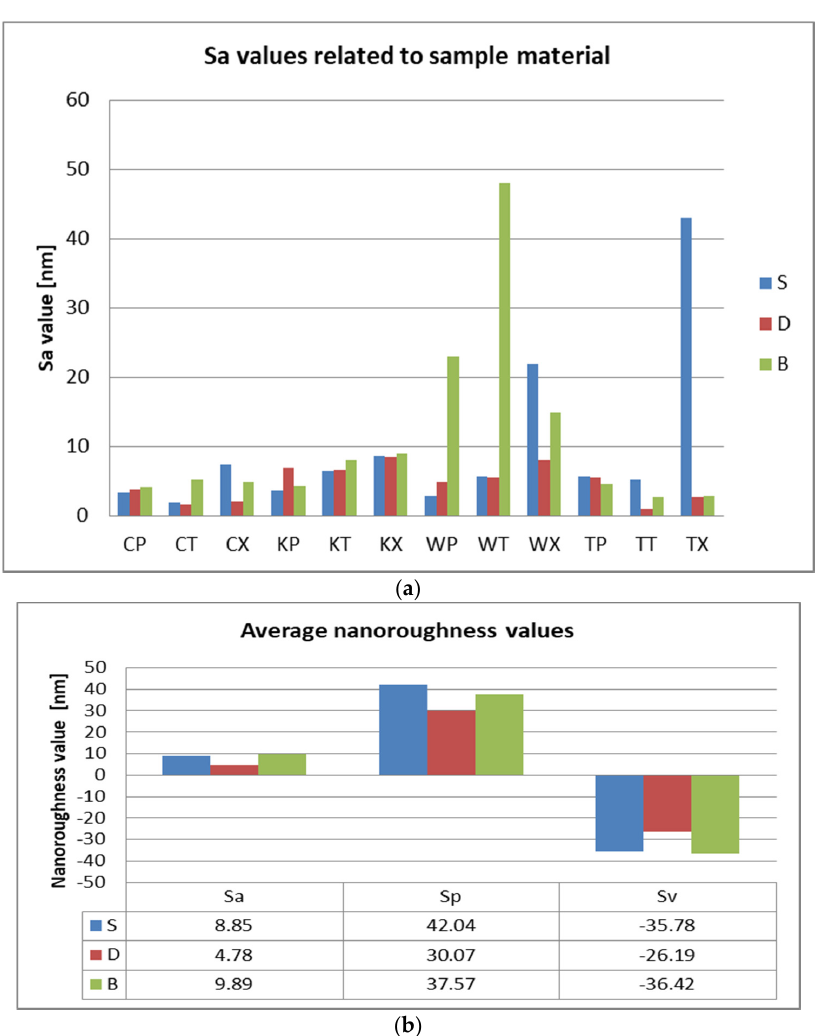
Figure 15. Nanoroughness values related to sample material (S, D, B): ( a ) Sa values. ( b ) average Sa, Sp, and Sv values. Polymers 2020 , 12 , x FOR PEER REVIEW